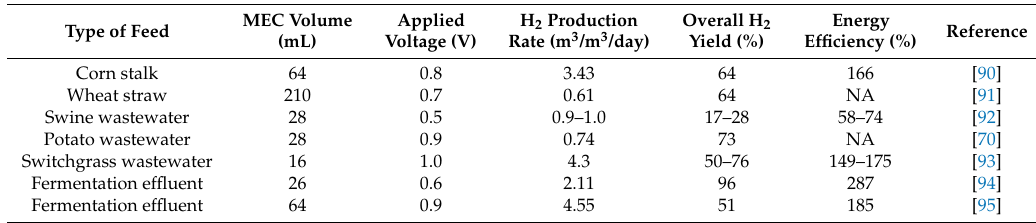
Table 3. H 2 production in microbial electrolysis cells (MECs) from different types of agricultural